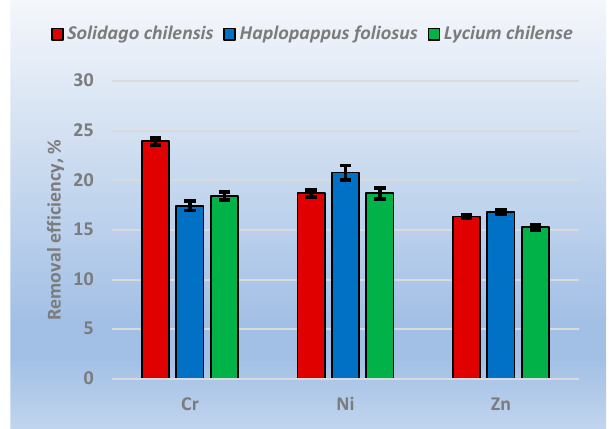
Figure 4. Removal efficiency.